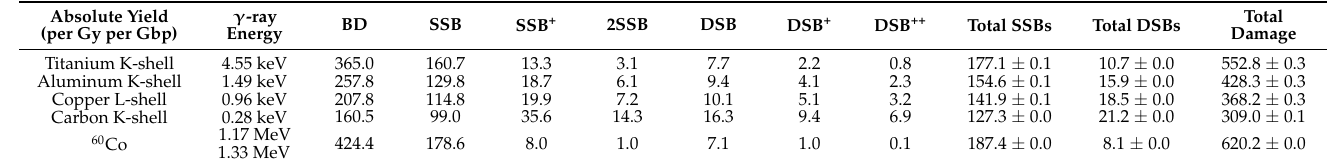
Table 2. Absolute yields of DNA damage (per Gy per Gbp) induced by ultrasoft X-rays and 60 Co γ -rays at a normal oxygen concentration (21%).